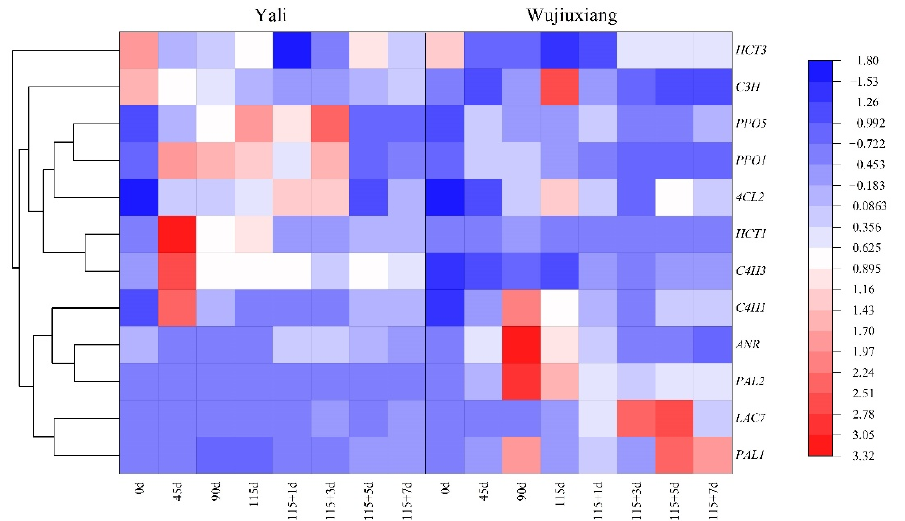
Figure 5. Expression profiles of genes involved in phenolic biosynthesis and metabolism in the peels of ‘Yali’ and ‘Wujiuxiang’ pears during cold storage and the shelf life. Note: 115 + 1, 115 + 3, 115 + 5, and 115 + 7 indicate 1, 3, 5, and 7 days of shelf life at room temperature (20 °C) after cold storage at 0 °C for 115 days. Red and high positive values indicate high gene expression, while blue and low negative values indicate low gene expression.